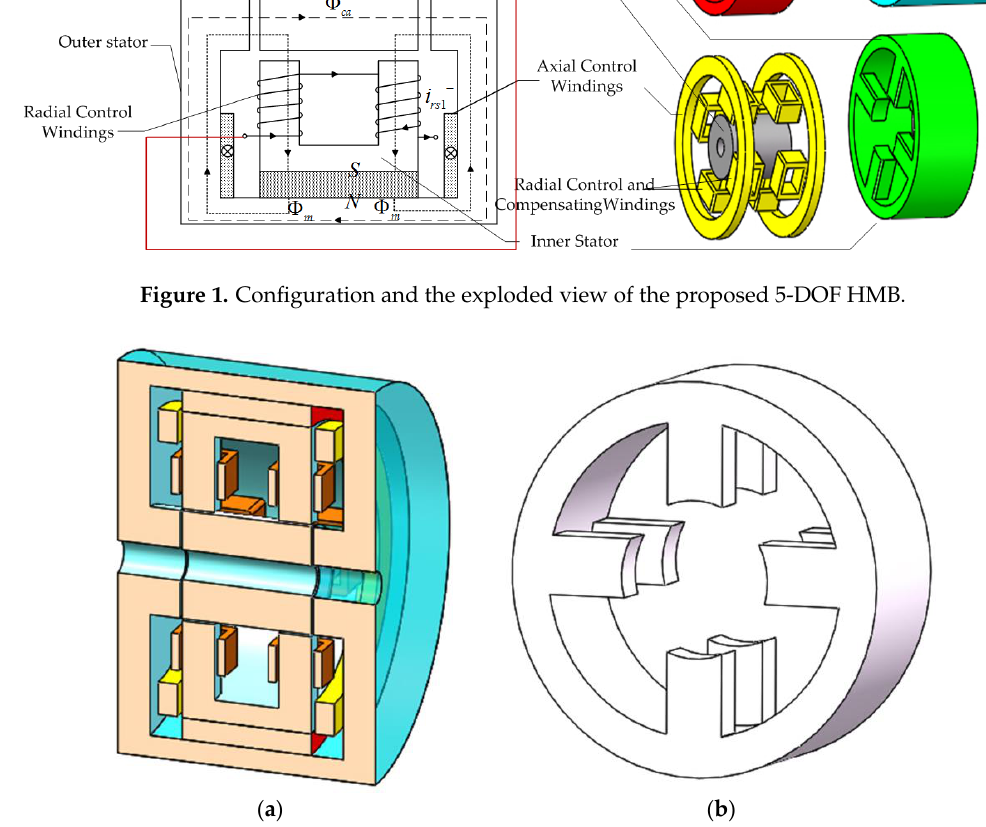
Figure 2. The inner stator core and cutaway view of the proposed 5-DOF HMB. ( a ) Cutaway view of the proposed 5-DOF HMB; ( b ) the structure of the inner stator core.